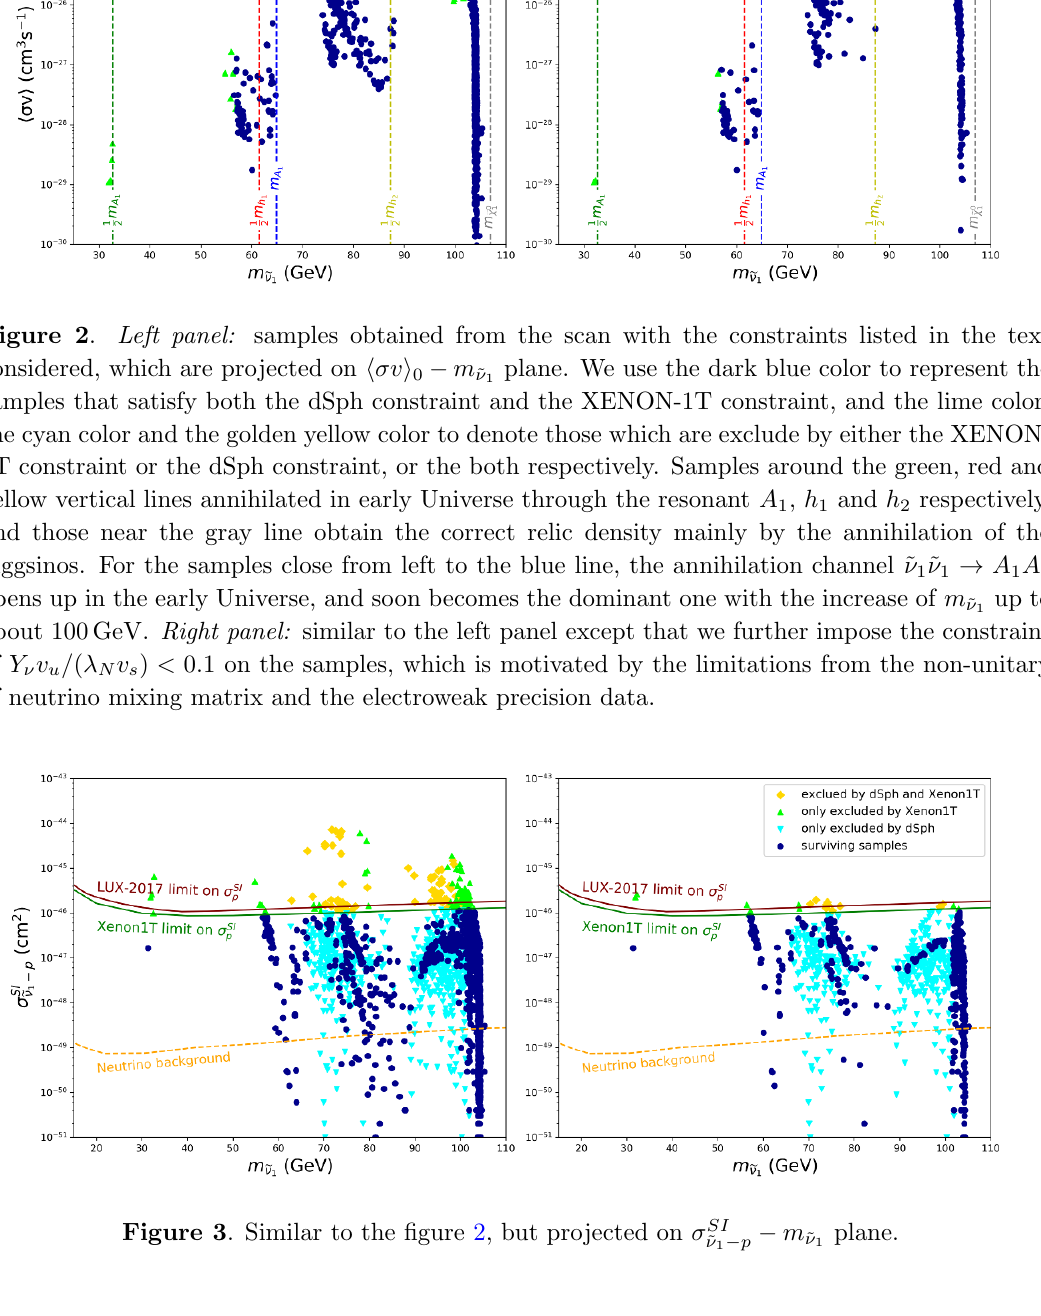
plane (left panel) and a (cid:0) a plane (right panel) respectively, where the green samples d 1 d 2 are excluded by the XENON-1T experiment, and the dark blue ones are not. The left